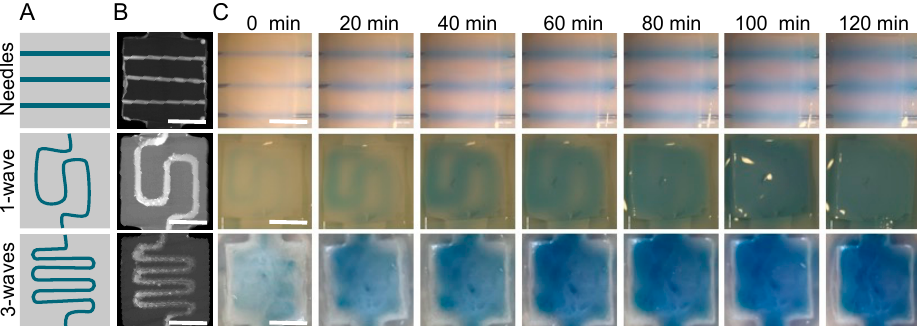
Figure 5. Medium diffusion perfusion channels made with three different geometries. ( A ) Perfusion channel design. ( B ) MicroCT imaging. ( C ) Medium diffusion over time when perfused at 0.05 mL·min − 1 . First line: 3 needles (23 G 600 µm external diameter). Second line: 1 wave geometry made with a sacrificial matrix of HIPS. Third line: three-waves geometry made with a sacrificial matrix of HIPS. All gels were perfused at 0.05 mL·min − 1 and followed every 20 min for 2 h. Scale bar: 5 mm.